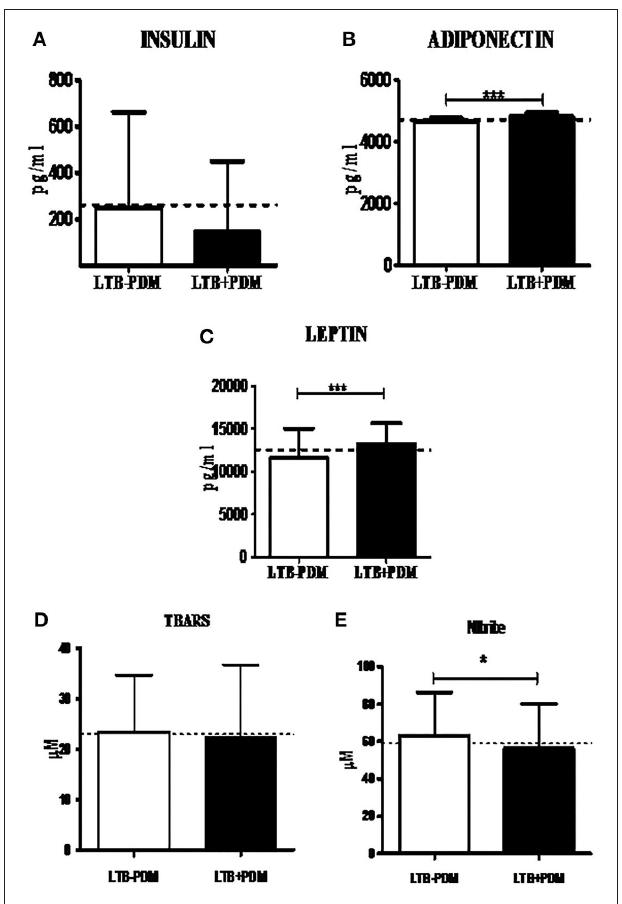
FIGURE 4 | LTBI increases Leptin and Adiponectin levels and decreases nitrite levels in PDM subjects. The circulating levels of hormones and redox markers in PDM subjects were quantified by ELISA and colorimetry, respectively. Bar graph showing the circulating levels of Insulin (A) , Adiponectin (B) and Leptin (C) , TBARS (D) , and nitrite (E) levels in the serum of LTB + PDM ( n = 47) and LTB-PDM ( n = 47) subjects. The basal level, as was seen in LTB-NGT, is shown as dashed line (—-), as reference. Statistical significance was determined by non-parametric Mann–Whitney U -test and p < 0.05 was considered significant. * p < 0.05; *** p < 0.001 for LTB-PDM vs. LTB + PDM.